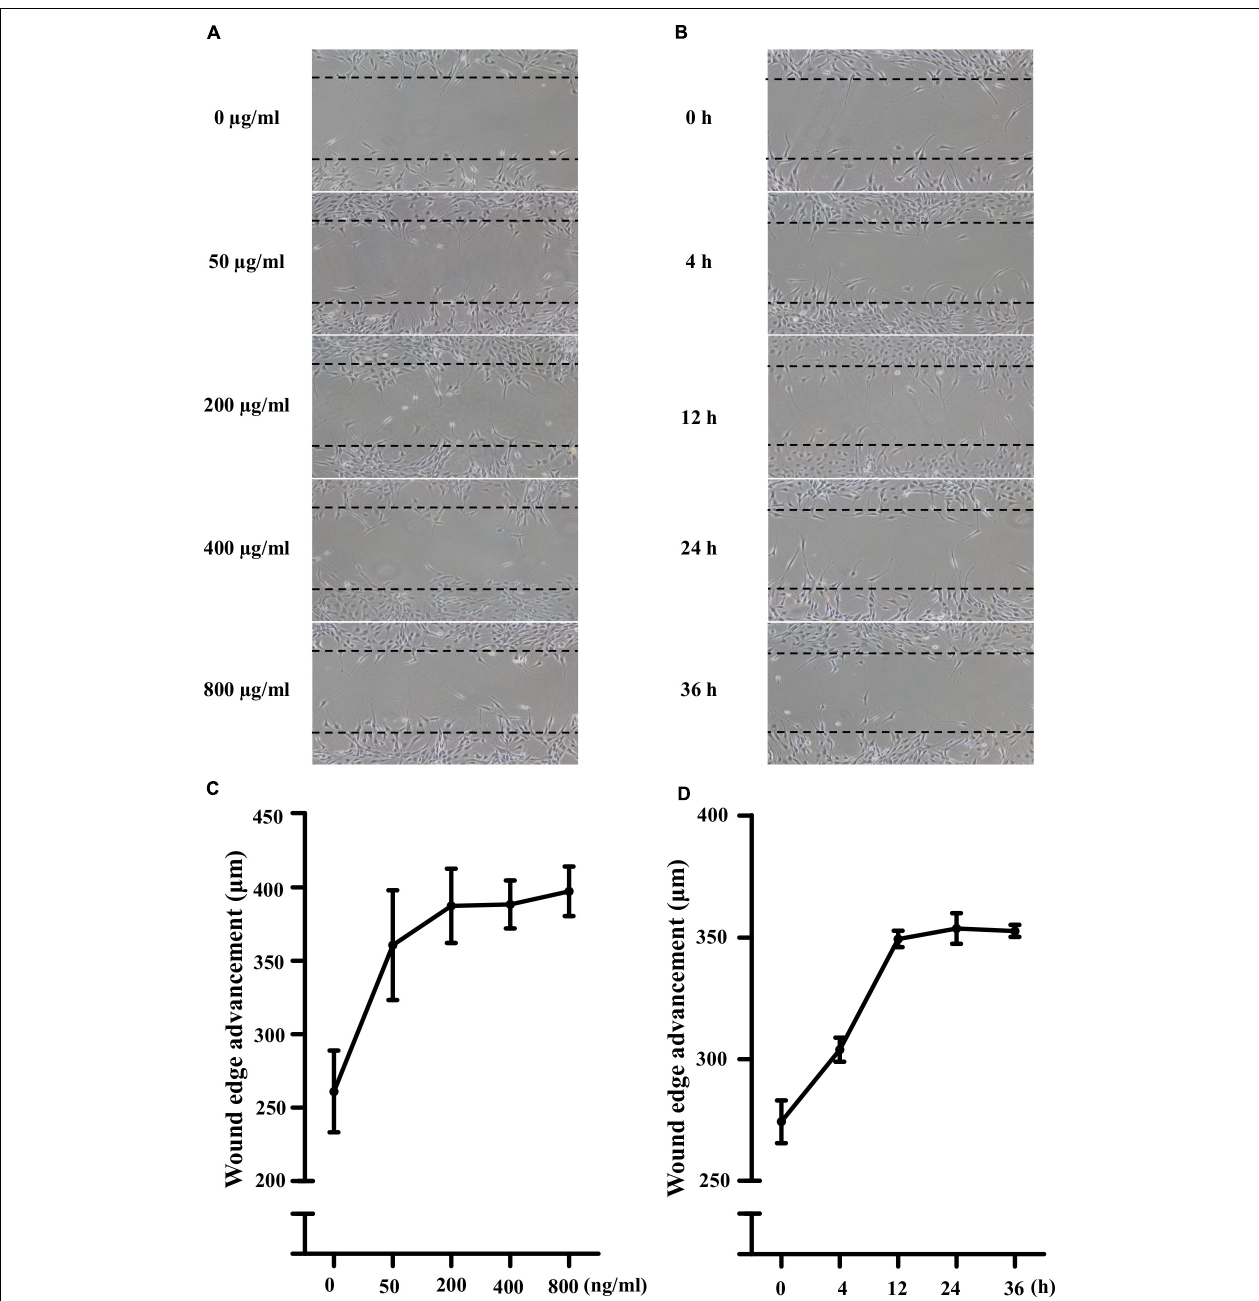
FIGURE 1 | Lipopolysaccharide (LPS) activated the migration potential of NIH3T3 cells in dose- and time-dependent manners. (A,C) Treatment of NIH3T3 cells with LPS (0, 50, 200, 400, and 800 ng/ml) for 24 h activated migration of cells in a dose-dependent manner. (B,D) Treatment of NIH3T3 cells with 400 ng/ml LPS in the inductive period (0, 4, 12, 24, and 36 h). The wound edge advancement was counted by the photomicrographs under microscope and the results were measured using Image Pro Plus software. All assays were performed at least three